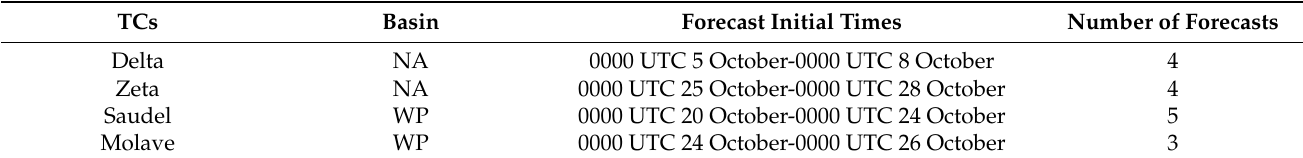
Table 1. List of TCs used in experiments. One forecast is made at 0000 UTC every day. The North Atlantic and West Pacific are abbreviated as NA and WP, respectively.